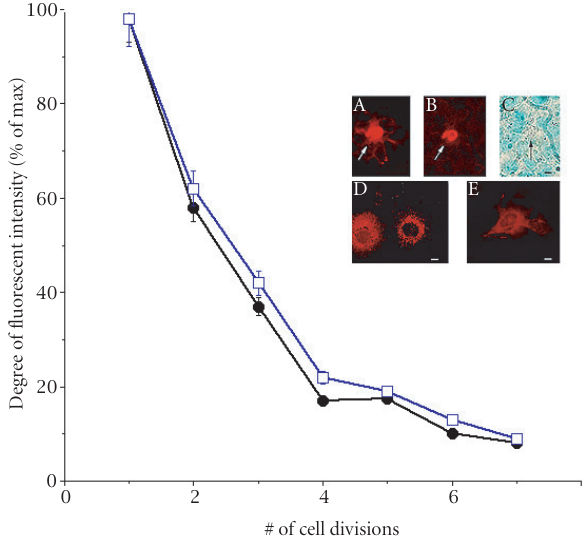
Figure 1: Graph depicting the number of divisions HC-11 cells un- dergo while losing TLC label. In cells that reached 5 ± 1 generations, over 80% of TLC label was lost. HC-11 cell morphologies ( (cid:1) ) and C57BL/6N mouse primary epithelial cultures ( (cid:1) ) that were scanned for fluorescent intensities and grown according to materials and methods. Inset, bright TLC labeled stem cell surrounded by differ- entiated progeny using IF (A), phase contrast (B) and bright field microscopy (C). Arrow in (C) represents pale counterstained stem cell. (D), Differentiated cell and its nearby differentiated daughter cell. (E), One of 4 differentiated HC-11 morphologies that can be labeled using the TRITC cell linker. Scale bars (A–E) 15 µ